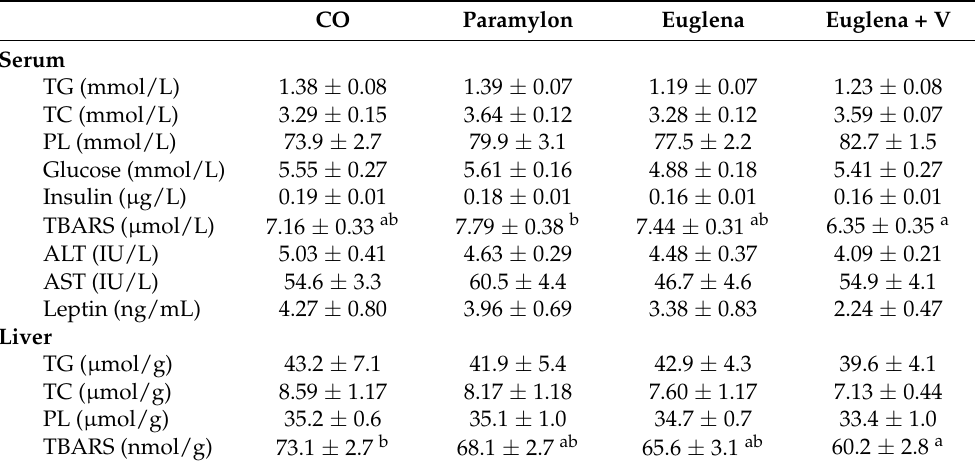
Table 4. Biochemical parameter in serum and liver.